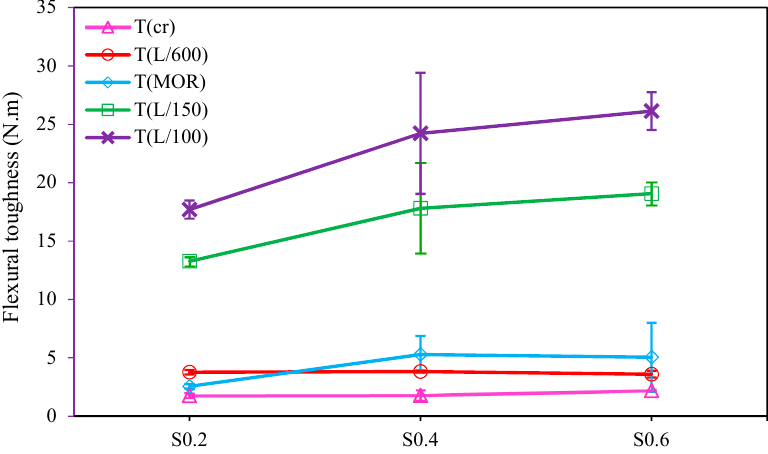
Figure 9. Impact of RTSF dosage on the flexural toughness of FR-AASCs.